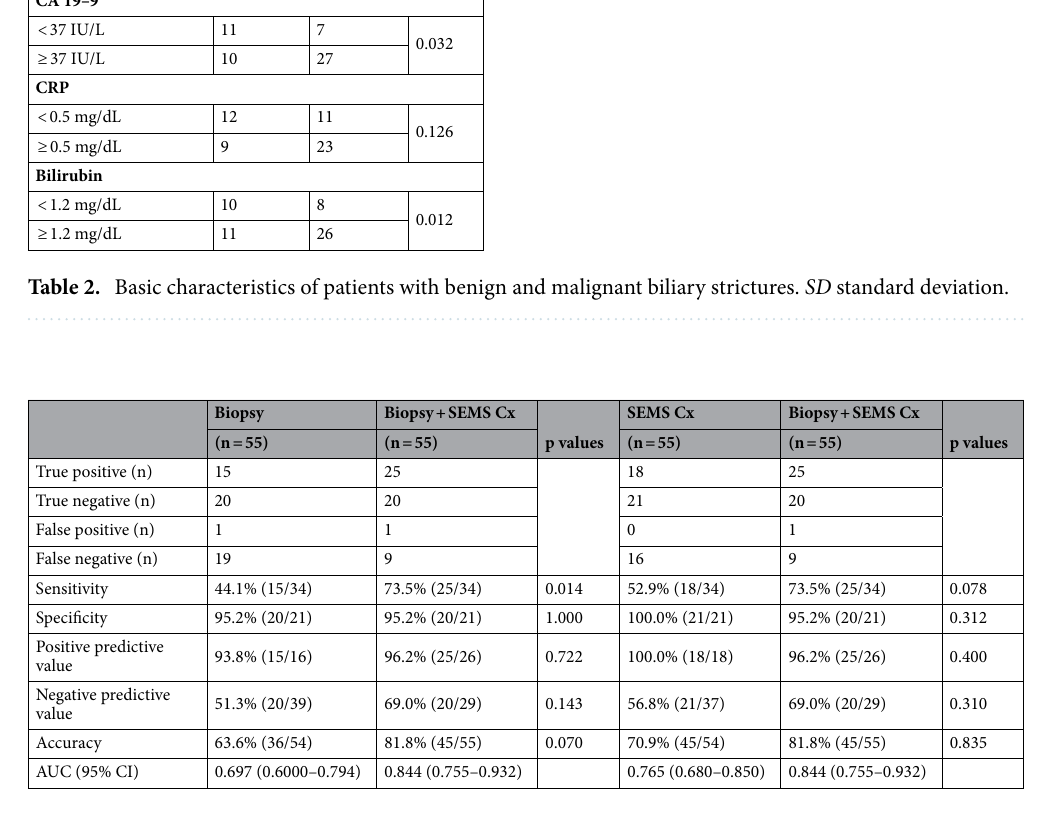
Table 3. Sensitivity, specificity, and accuracy rates of the diagnostic methods. AUC area under the curve, CI confidence interval, SEMS Cx self-expendable covered metal stent